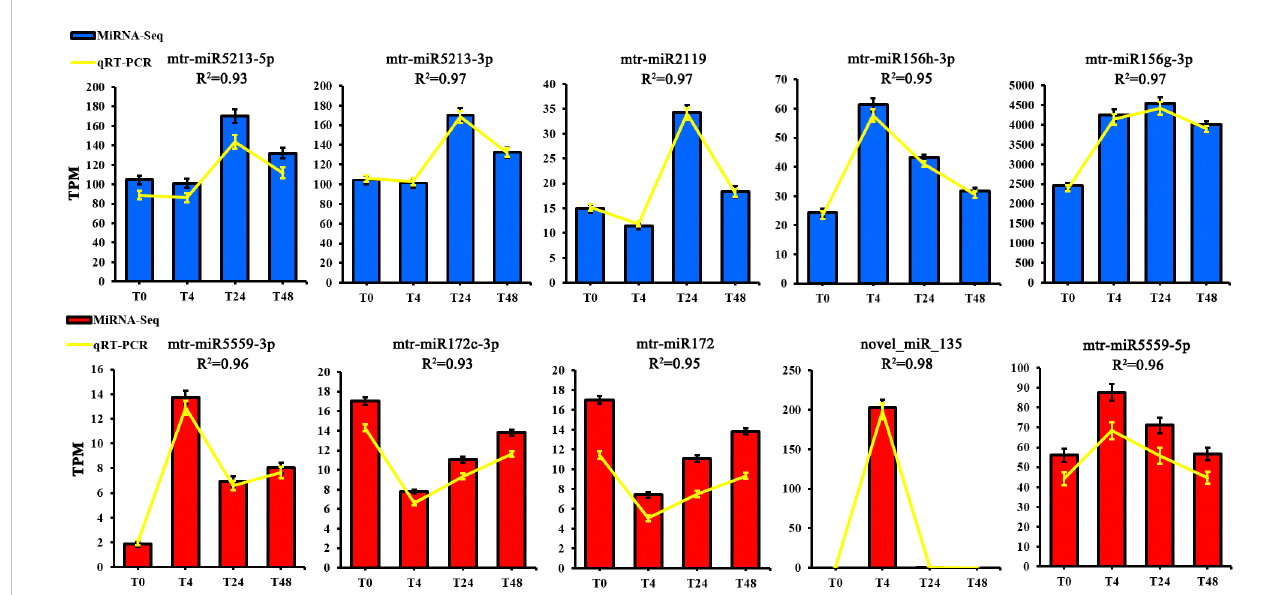
FIGURE 4 The expression patterns of ten selected miRNAs identi fi ed by RNA-Seq were veri fi ed by qRT-PCR. The Y-axis to the left of each histogram represents the expression level of RNA-seq (TPM). T0 to T48 represents M. truncatula plant samples treated with aluminum for 0h, 4h, 24h, and 48h,